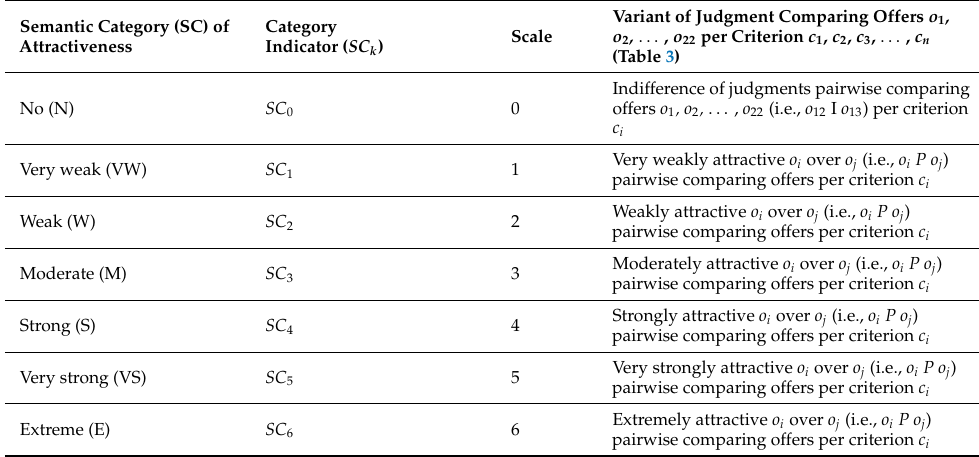
Table 4. Semantic scale